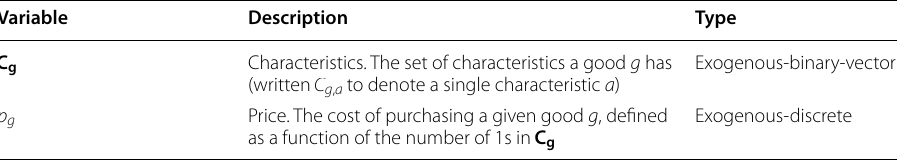
Table 2 Goods’ variables, description and type